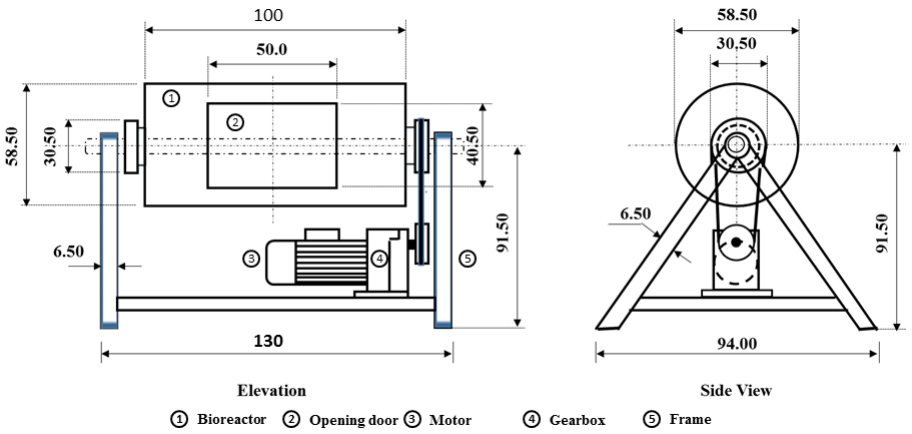
Figure 1. Schematic diagram showing two views of the constructed rotary drum bioreactor system; dimensions in cm, not to scale.